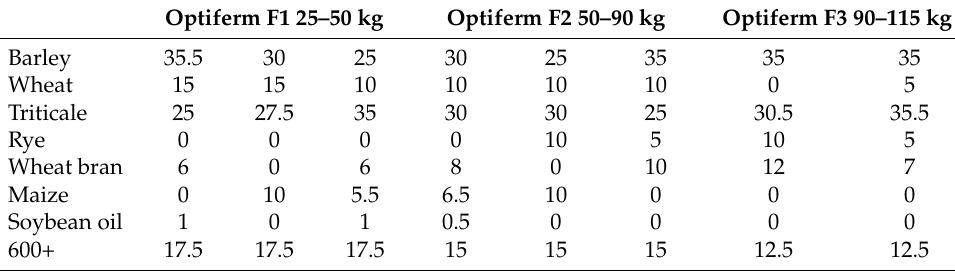
Table 2. Feeding program for Dan Bred fattening pigs depending on weight [51].